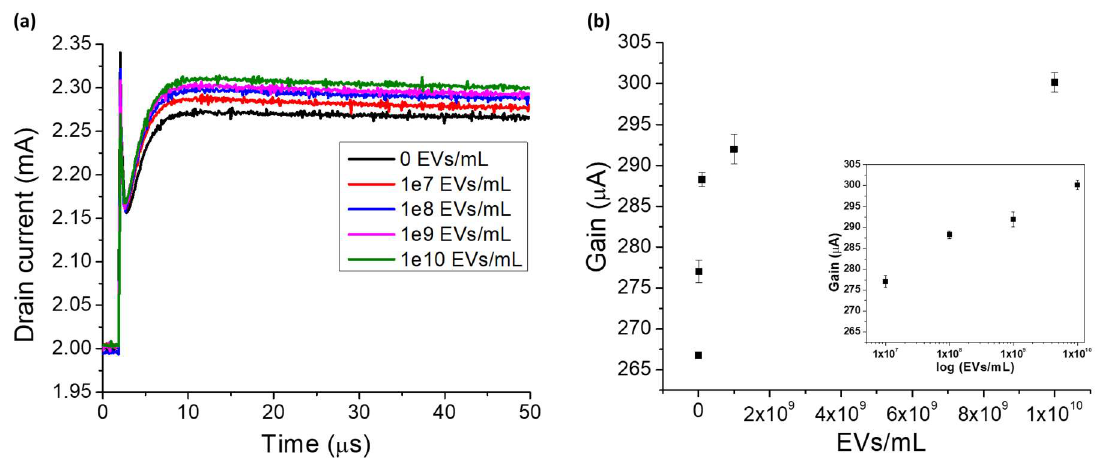
Figure 4. ( a ) Drain current versus time for different EV concentrations. ( b ) Sensor response curve for EV enumeration. Inset shows response in log scale.